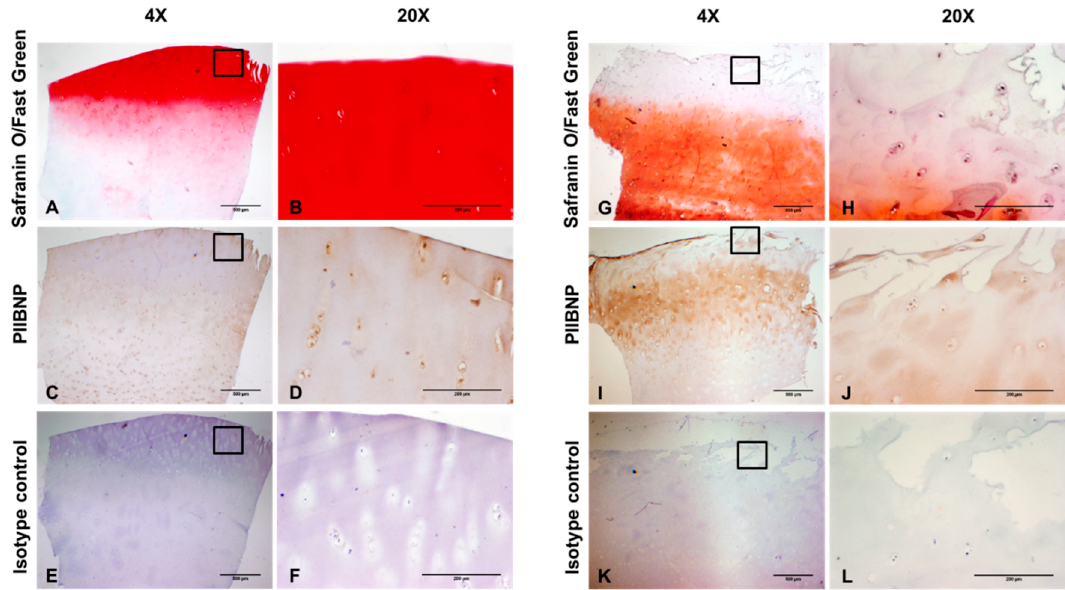
Figure 2. Immunolocalization of PIIBNP in normal ( A – F ) and OA ( G – L ) human articular cartilage. ( A , G ) Safranin O/Fast green histology staining, 4× magnification; ( B , H ) Higher magnification (20×) images of the squares in panel A+G are shown; ( C , I ) Immunolabeling with an anti-PIIBNP antibody, 4× magnification; ( D , J ) Higher magnification (20×) images of the squares in panel C+I are shown; ( E , K ) IgG1 isotype control, 4× magnification; ( F , L ) Higher magnification (20×) images of the squares in panel E+K are shown. Scale bar: 500 µm ( A , C , E , G , I , K ), 200 µm ( B , D , F , H , J , L ).